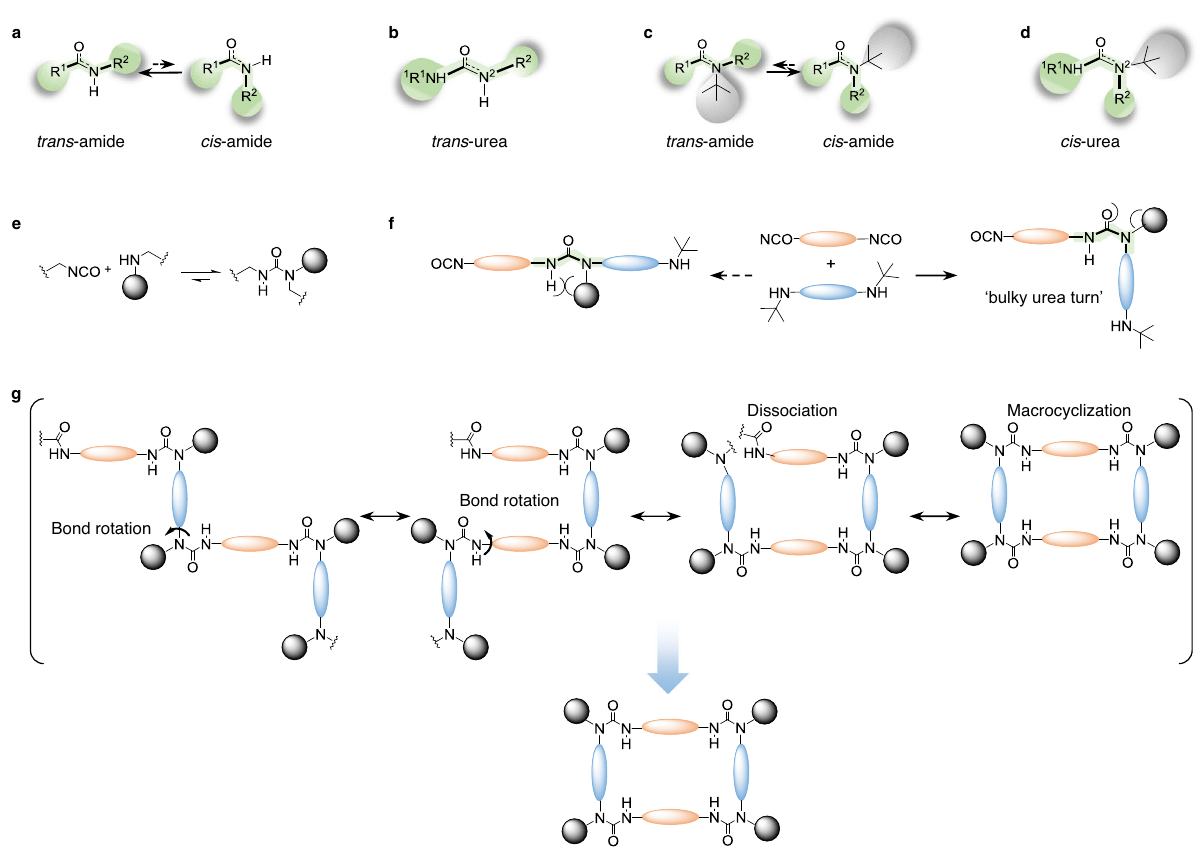
Fig. 1 Rationale for the ef fi cient construction of HUMs. a Trans conformation preference of typical unhindered amide. b Trans conformation preference of typical unhindered N, N ′ -di-substituted urea. c Cis conformation preference of amide with bulky N -substituent. d Proposed cis conformation of ureas with bulky N -substituents. e Schematic illustration of the hindered urea bond (HUB). The bulky substituent broke the bond co-planarity, rendering HUB dynamic. f Schematic illustration for ‘ bulky urea-turn ’ and hindered urea chains. g Schematic illustration for the cis -urea facilitated macrocyclization. If the bulky group induced ‘ cis -urea preference ’ holds true, the hindered urea chain will bend and can easily undergo macrocyclization with several bond